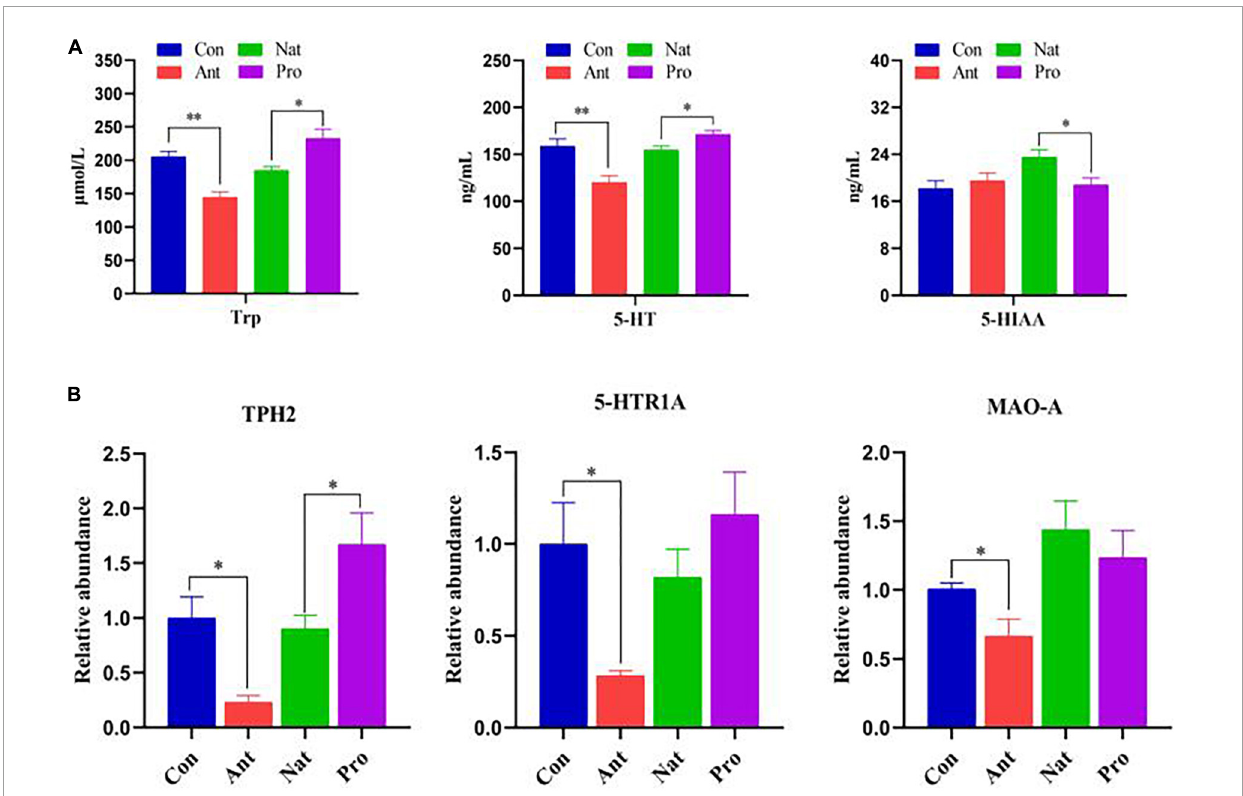
FIGURE6 Effects of dietary probiotic supplementation on the levels of 5-HT metabolism-related proteins in the hypothalamus and serum of antibiotic-treated hens. (A) Graph showing the concentration of Try, 5-HT, and 5-HIAA in the serum of laying hens ( n = 7). (B) Graph showing the relative mRNA levels of TPH-2, 5-HTRl A and MAO-A in the hypothalamus of laying hens ( n = 7). Data were normalized to β -actin and the significance defined as ∗ P < 0.05, ∗∗ P <